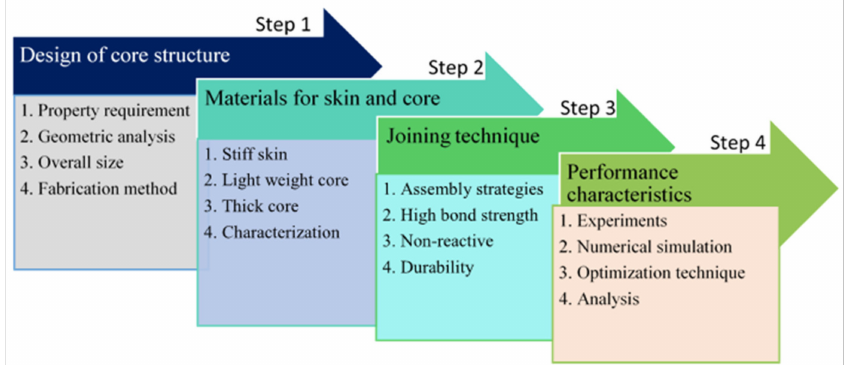
Figure 2. Steps to achieve advanced sandwich structure with extraordinary performance.